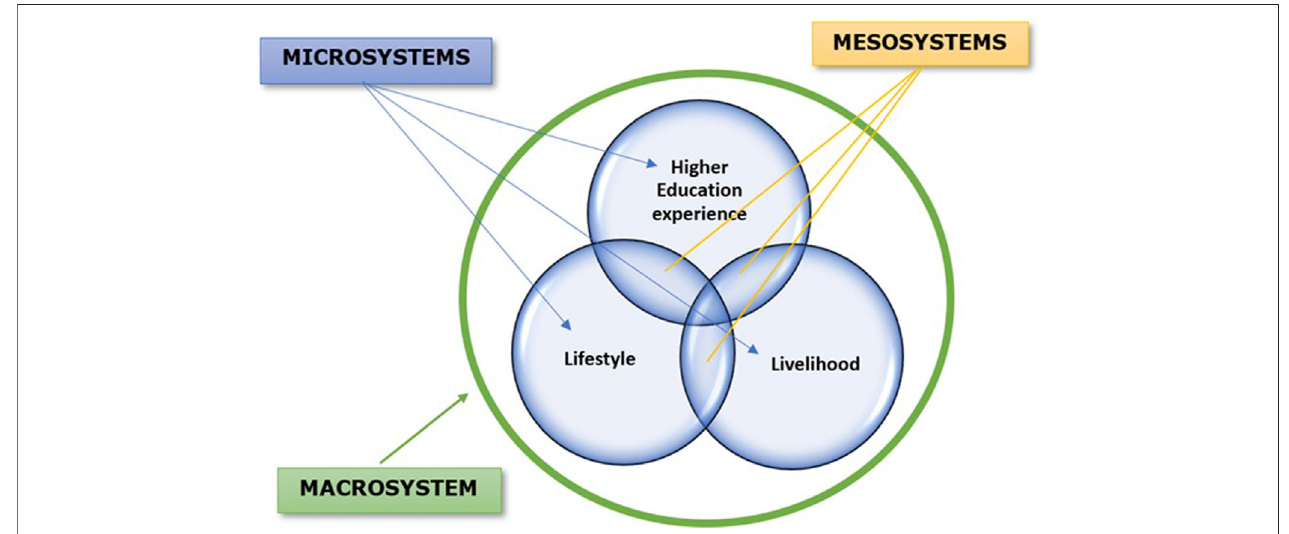
FIGURE 1 | An ecological systems model of higher education, livelihood and lifestyle experiences. Note: Based on Voydanoff (2007) adaption of Bronfenbrenner (1979) ecological systems model.